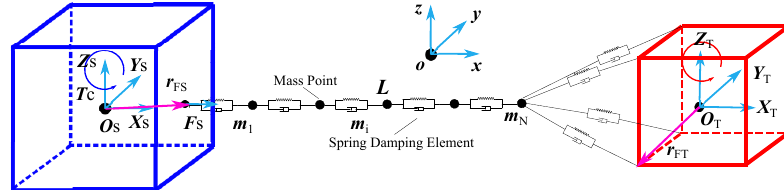
Figure 7. Concept of the lumped-mass model for a sub-tether